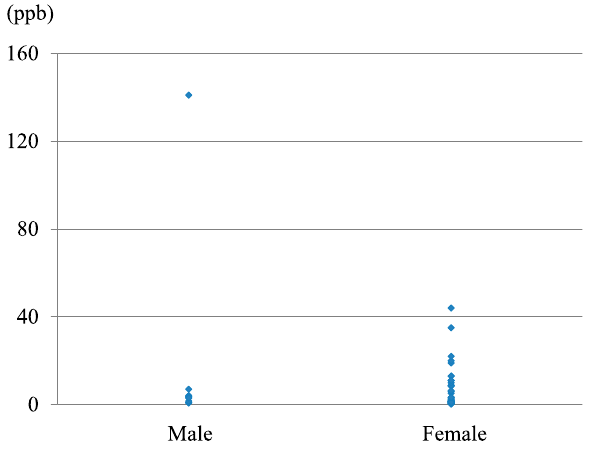
Figure 2 Serum cobalt ion concentration and sex No correlation was observed between sex and the serum cobalt ion concentration.